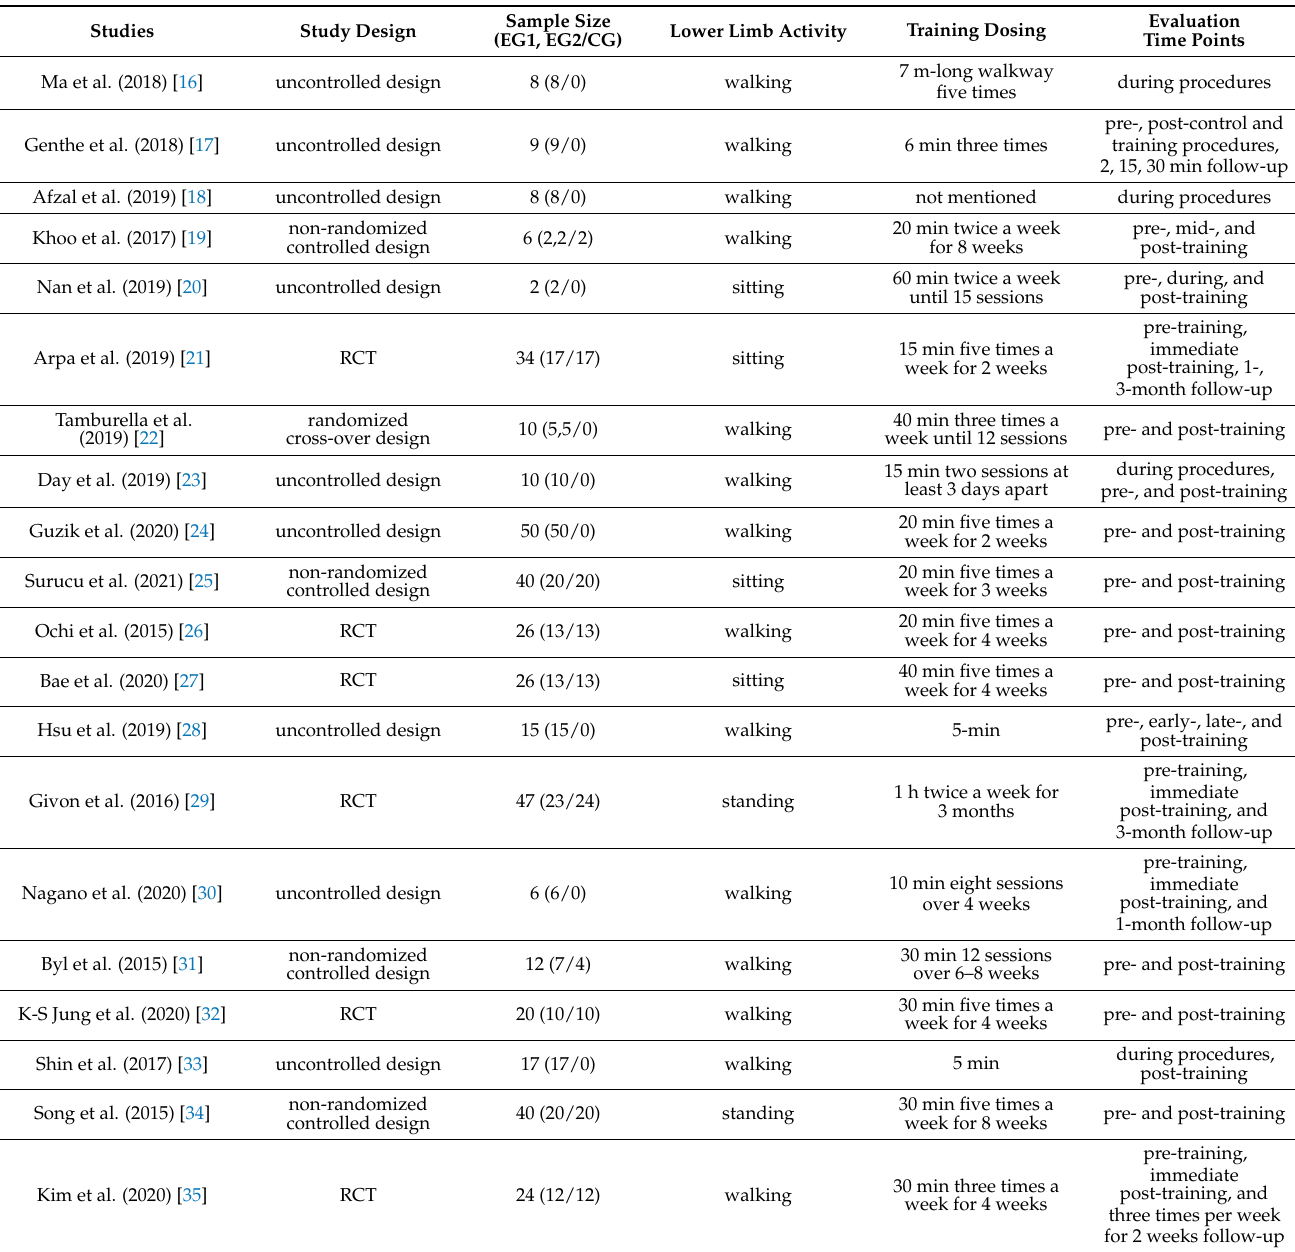
Table 2. Clinical specifications (RCT: Randomized Controlled Trial, EG: Experimental Group, CG: Control